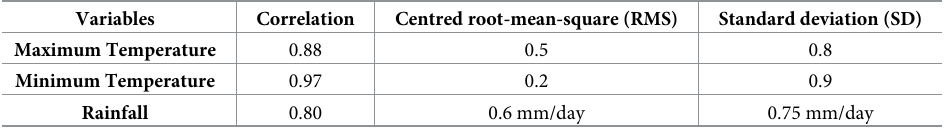
Table 6. Summary of Taylor diagrams for maximum, minimum temperature and precipitation, comparing obser- vations with CMIP5 models and ensemble mean simulations for Olifant River Catchment for the period 1976–